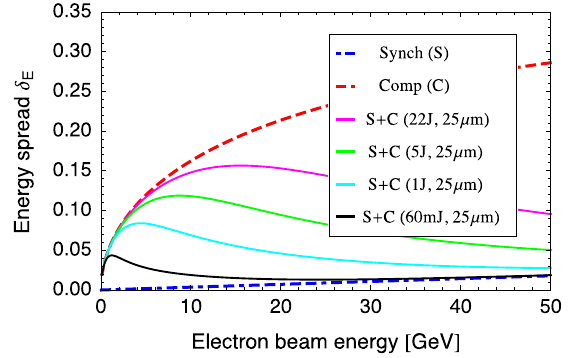
FIG. 5. ThomX ring equilibrium transverse emittance. The natural emittance ( “ Synch ” ) is calculated taking into account the lattice of the ThomX ring. A 1 μ m wavelength laser is used for estimating the Compton induced emittance ( “ Comp ” ). The final equilibrium transverse emittance ( “ S þ C ” ) is given for four different laser pulse energies and for the electron and laser beam ¼ 25 μ size of σ e;L